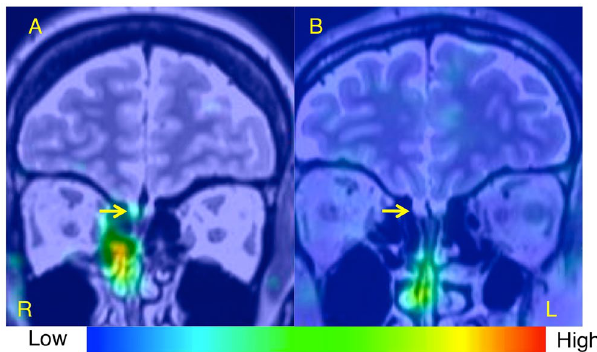
Figure 3. Single photon emission computed tomography (SPECT), X-ray computed tomography (CT), and magnetic resonance imaging (MRI) Olfacto-scintigraphy in representative cases with idiopathic olfactory dysfunction. ( A ) A case of better prognosis was a 49-year-old female who had relatively high nasal 201 Tl migration to the olfactory bulb (11.1%). ( B ) A case of worse prognosis was a 40-year-old male who had low nasal 201 Tl migration to the olfactory bulb